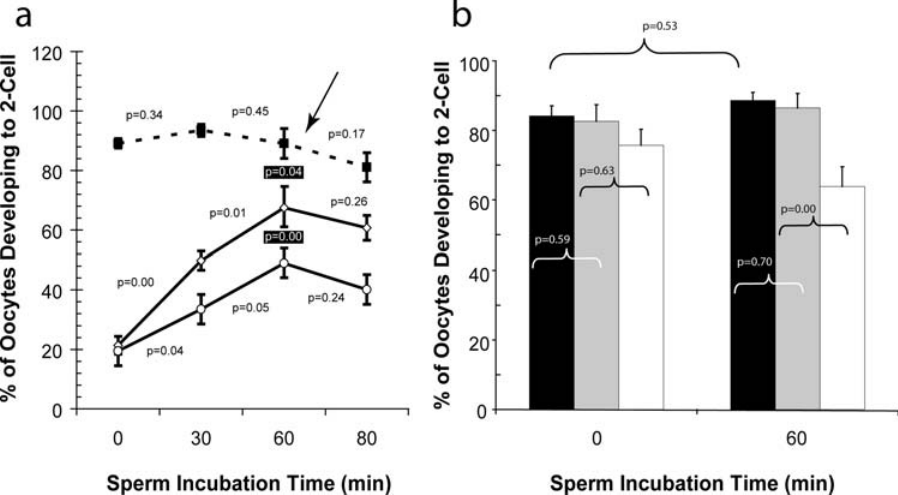
Figure 1. Influenceofspermpre-incubationon in vitro fertilizationsuccess. (a). Variability among males was limited by creating 3 pools of sperm, each containing sperm from 2 C57BL/6J males. Sperm treatments included cryopreservation in 3% skim milk, 18% raffinose ( # ); 3% skim milk, 18% raffinose supplemented with 477 m M monothioglycerol ( e ) and freshly collected in Cook’s Mouse Vitro Fert (MVF; & ). Sperm were cryopreserved and thawed using previously optimized cooling and warming rates. Three IVFs per treatment, each using cumulus oocyte masses from 2 superovulated C57BL/6J females (mean 6 standard deviation; 66 6 20 oocytes/IVF), were performed following 0, 30, 60, or 80 min of sperm incubation in MVF. Treatment effects were determined using ANOVA and preplanned contrasts between consecutive time points. The arrow and black boxed p-values indicate the reduced ability of cryopreserved C57BL/6J sperm to fertilize oocytes after 60 min of incubation when compared to freshly collected sperm using Dunnett’s Method[32]. (b) . Sperm were collected from 6 C57BL/6J males and 3 pools created, each containing sperm from 2 males. The pools were subdivided into 3 treatments: i) Control – no treatment (black); ii) Diluted live sperm – sperm were diluted 1:4 in MVF to mimic the concentration of live sperm equivalent to that found in cryopreserved samples (gray); and iii) Diluted live + dead sperm – live sperm were diluted 1:4 with killed sperm (flash frozen in liquid nitrogen) to simulate the number and ratio of live and dead sperm observed in the cryopreserved samples (white). The various treatments received either no incubation or 60 min of incubation in MVF before adding cumulus oocyte masses from two superovulated C57BL/6J oocytes (mean 6 standard deviation; 69 6 23 oocytes/IVF). In vitro fertilization was done at least six times for each treatment, twice per pool of males. Comparisons indicated were evaluated using preplanned